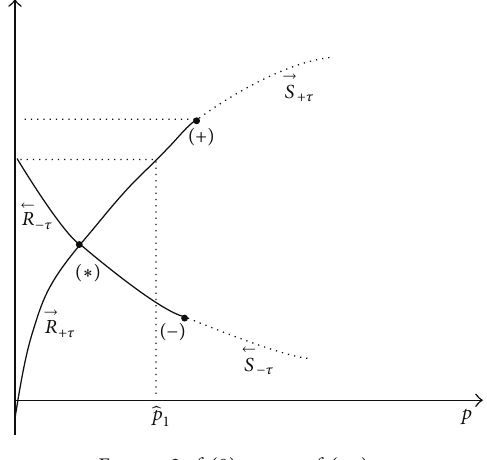
Figure 2: 𝑓 1 (0) ≤ 𝑢 + = 𝑓 2 (𝑝 + ) .